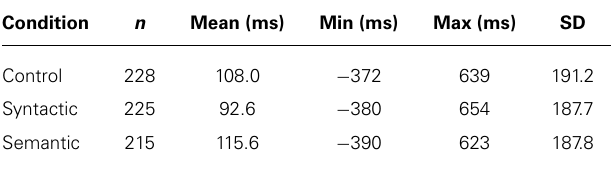
Table 3 |ATA descriptive statistics of the three conditions.